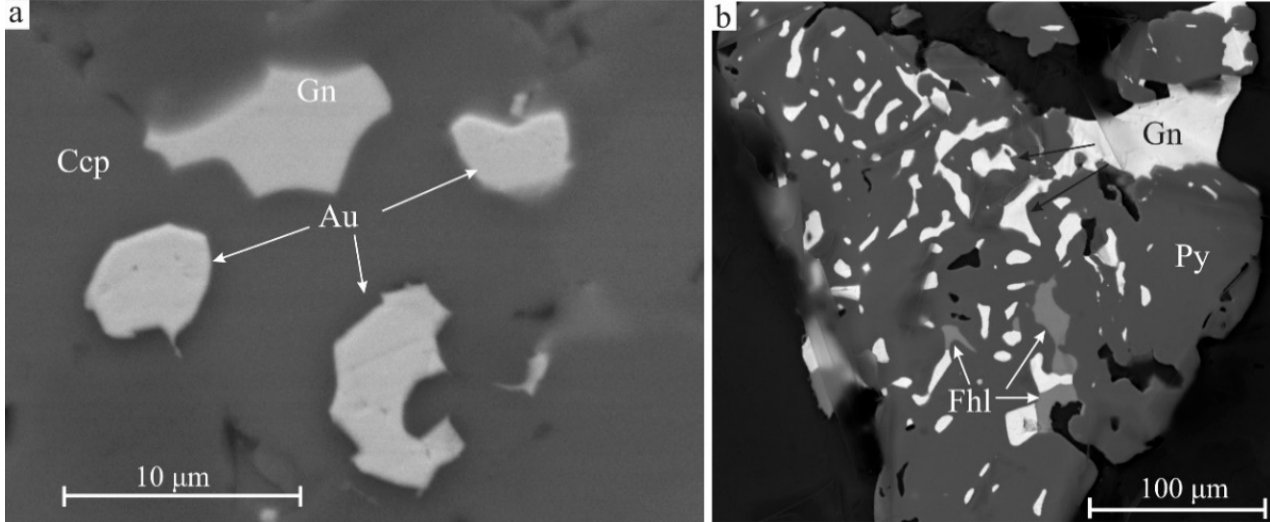
Figure 26. Gold and silver minerals in massive ore of the Novo-Uchaly lode. ( а ) Gold and galena inclusions in chalcopyrite, ( b ) Ag-bearing tetrahedrite and galena symplectites in pyrite.